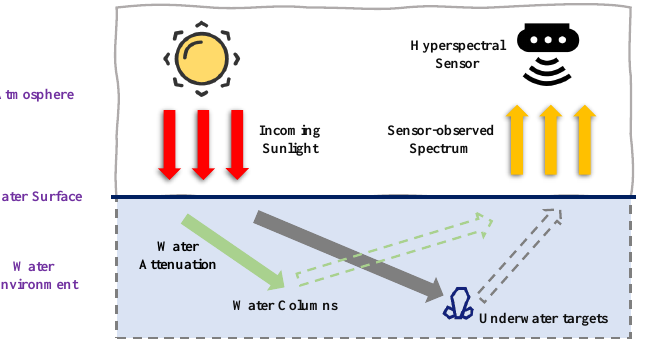
Figure 1. The illustration of the generation process for sensor-observed spectrum.